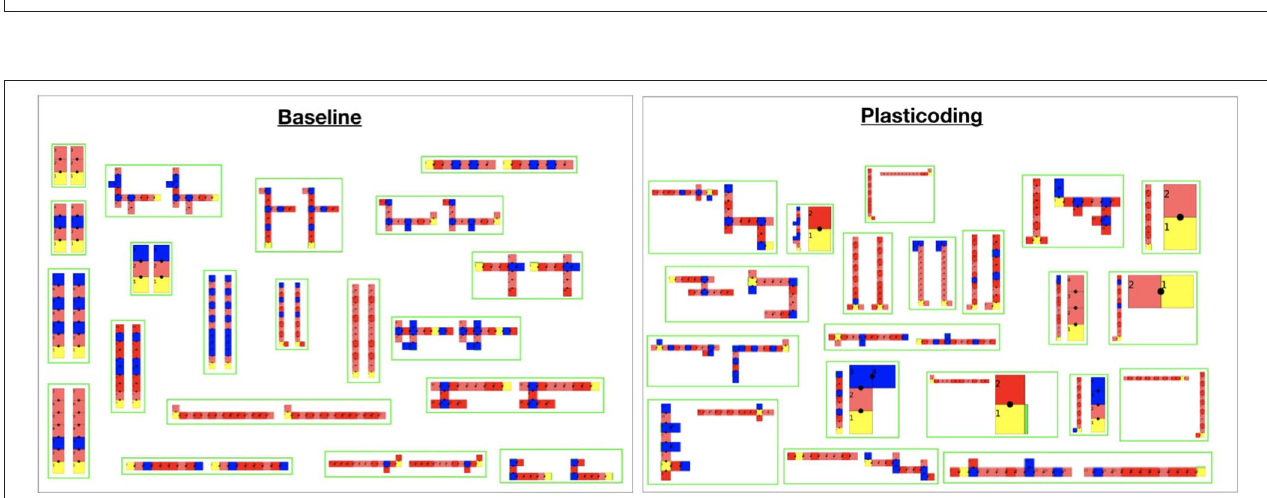
FIGURE 14 | Illustrations of the best robots for each experiment repetition using each encoding method. At the left of each green box is the morphology developed in the Flat season, while at the right is the morphology developed in the Tilted season. Note that for the Baseline, naturally, in each green box both morphologies are the same. These are top-down 2D illustrations that use a polygon representing each module, assuming every module is the same size: each polygon color is relative to one type of module, as described earlier in Figure 1 . Illustrations were rescaled to fit the frames accordingly. A video showing examples of best emergent robots is available on the link https://www.youtube.com/watch?v=43wsQfWMo-Q&feature=youtu.be.